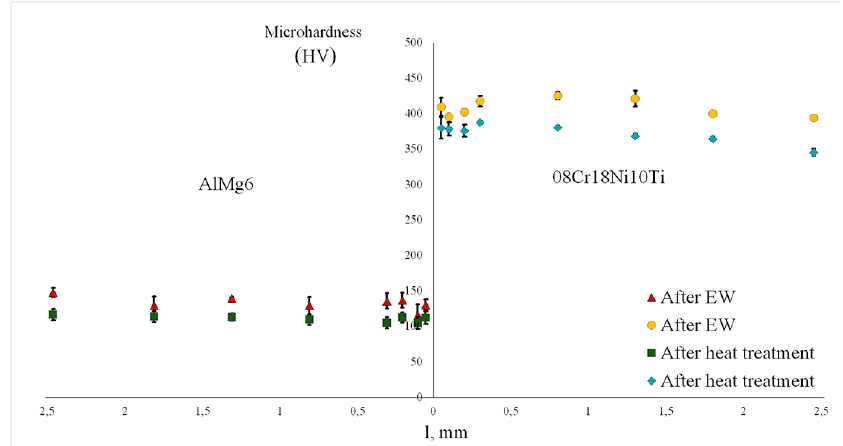
Figure 12. Microhardness of AlMg6–08Cr18Ni10Ti weld interface.